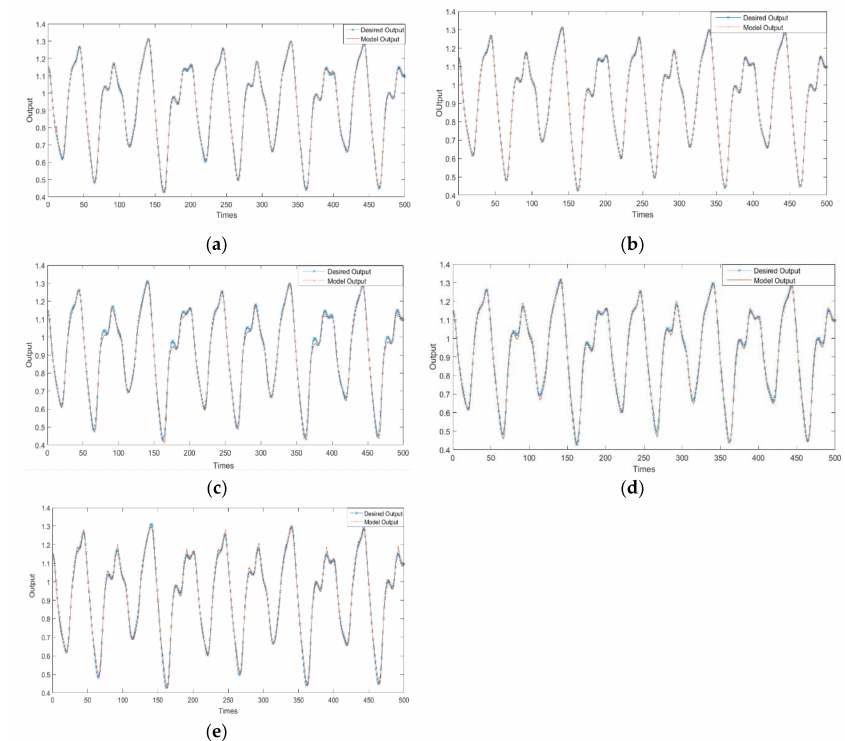
Figure 13. Chaotic time-series prediction results for ( a ) DGCPSO, ( b ) DE [24], ( c ) PSO [25], ( d ) QPSO [26], and ( e ) CPSO [27].